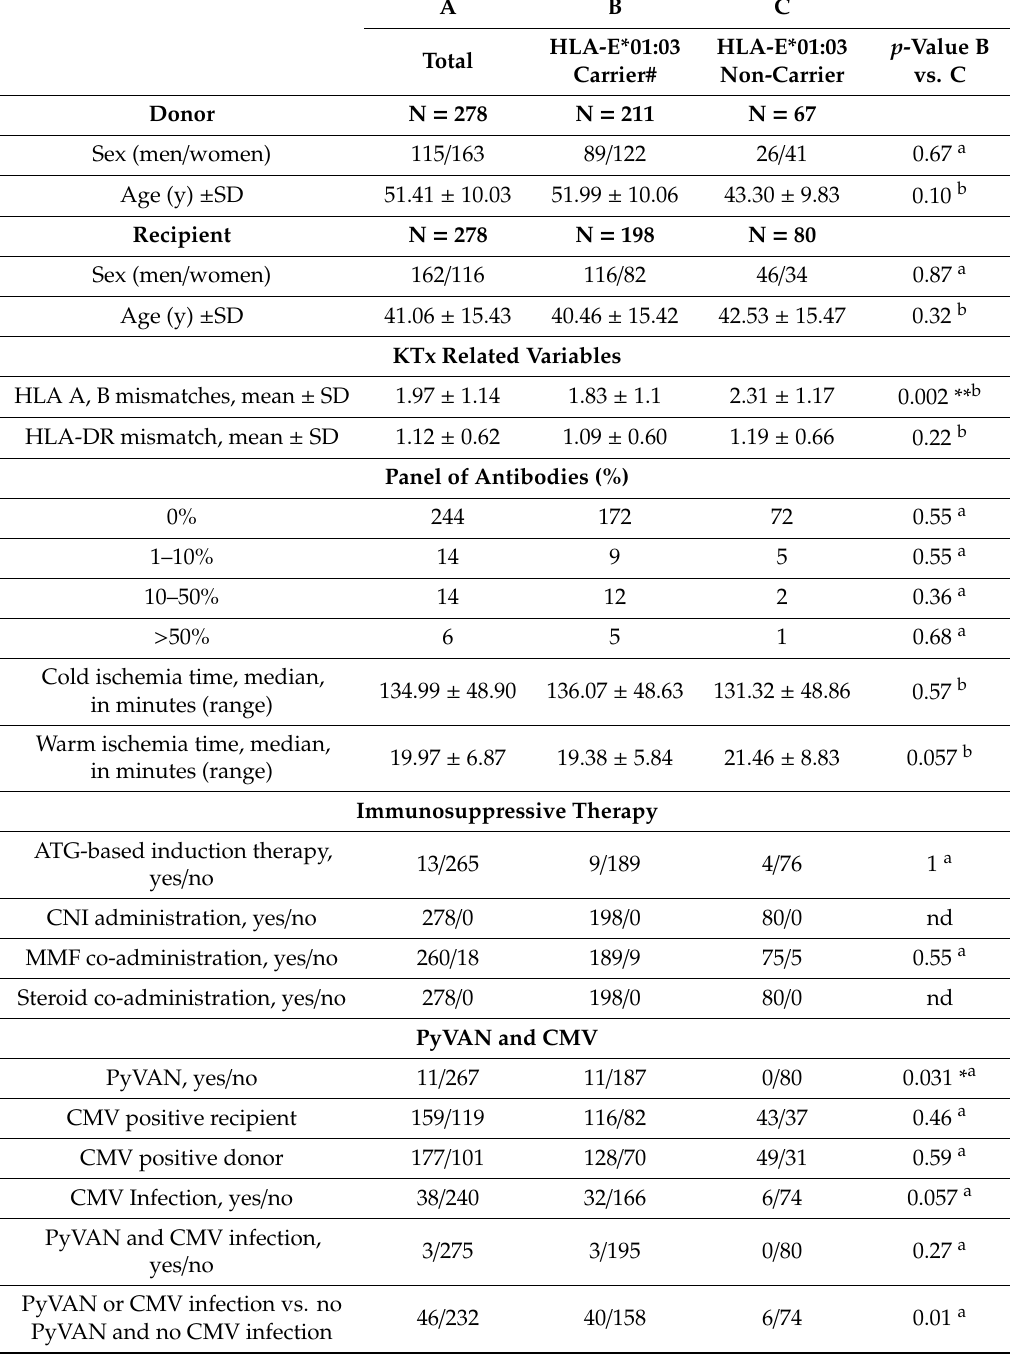
Table 1. Patient characteristics at